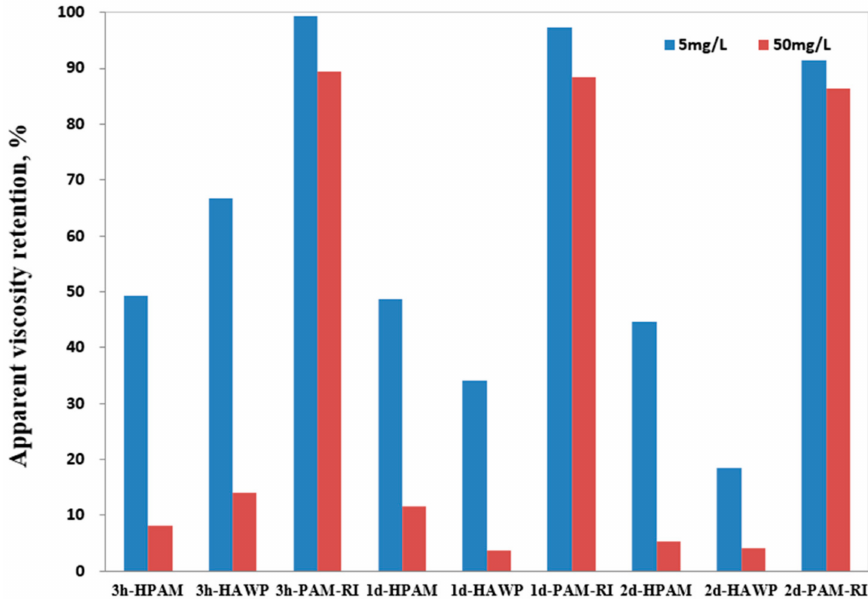
Figure 5. Apparent viscosity retention of polymer solutions with Fe 2+ concentrations of 5 mg/L and 50